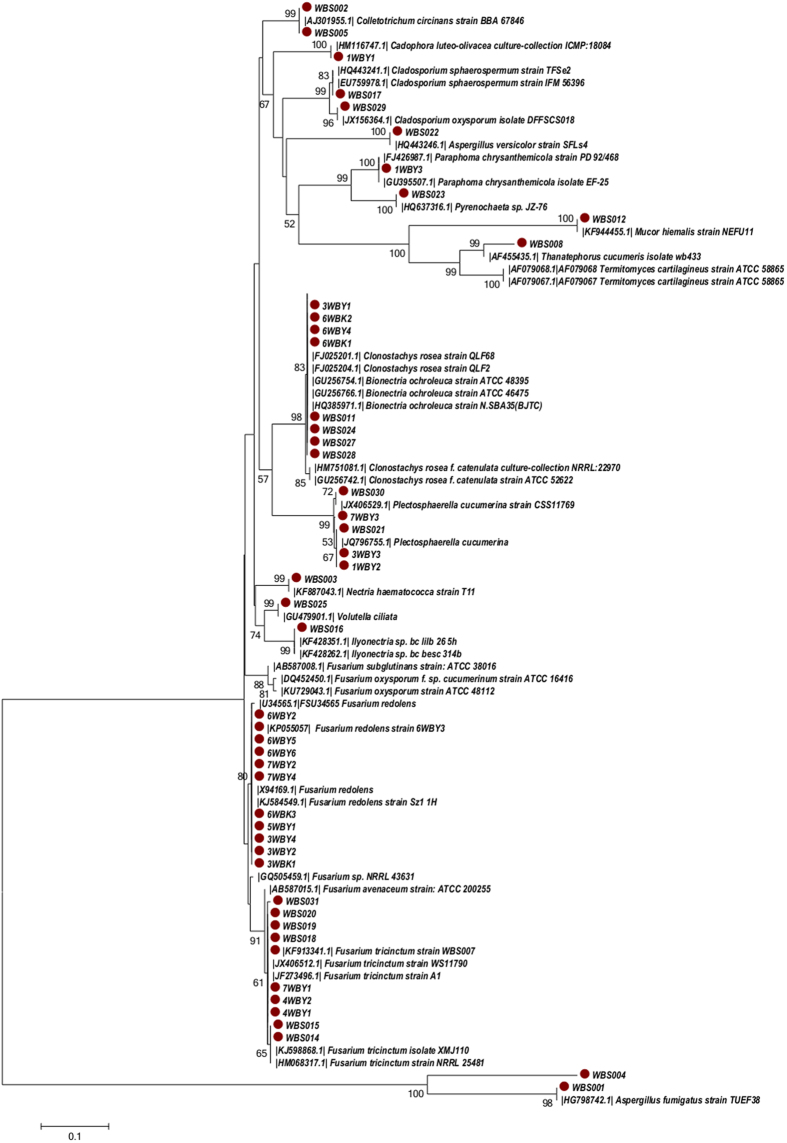
Neighbour-joining method analysis of ITS1-5.8S rDNA-ITS2 sequences from the endophytic fungi of Fritillaria unibracteata var. wabuensis.The tree was derived from the sequences of 49 endophytic fungi (marked with symbols) and 41 sequences retrieved from GenBank. The percentage of replicate trees in which associated taxa were clustered together in the bootstrap test (1000 replicates, values below 50% are not shown) are shown next to the branches. Phylogeny analyses were conducted in MEGA5.1 software.